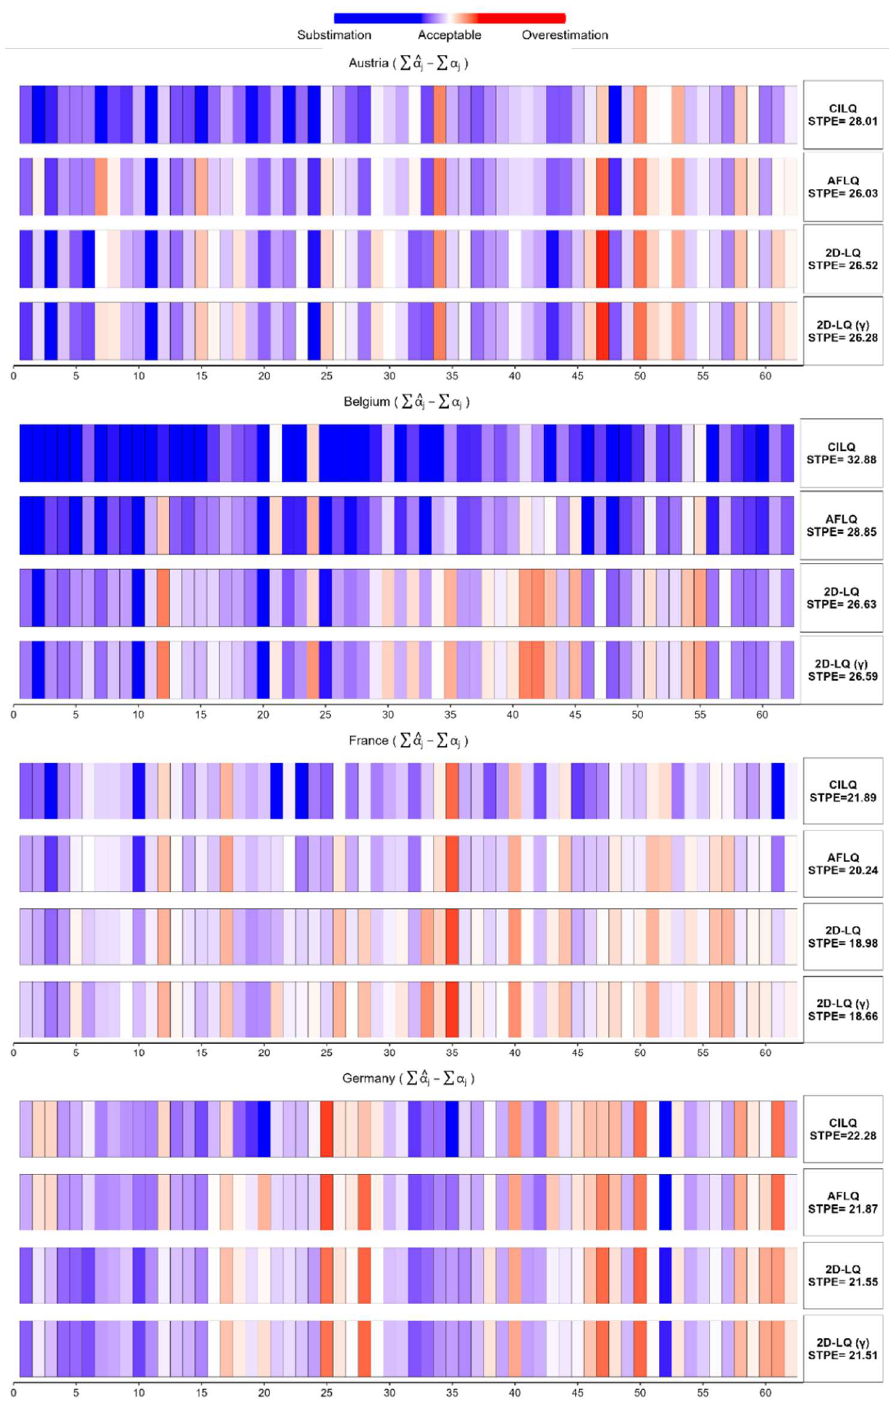
Figure 9. Errors in multipliers using LQ s for EA-19 countries. Source: internal based on Eurostat data [naio_10_cp1700].